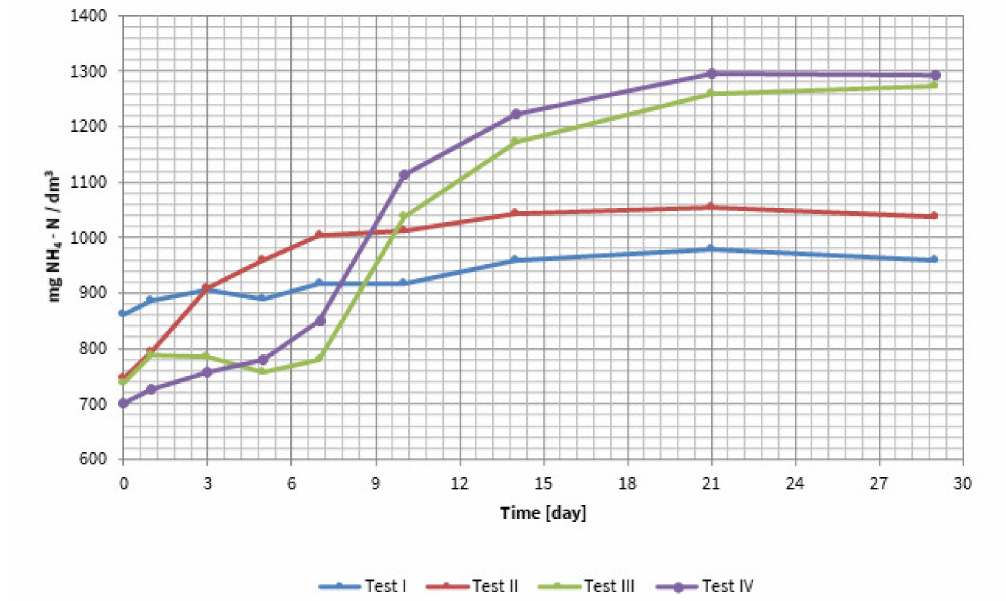
Figure 8. Changes in ammonia nitrogen concentration during co-fermentation